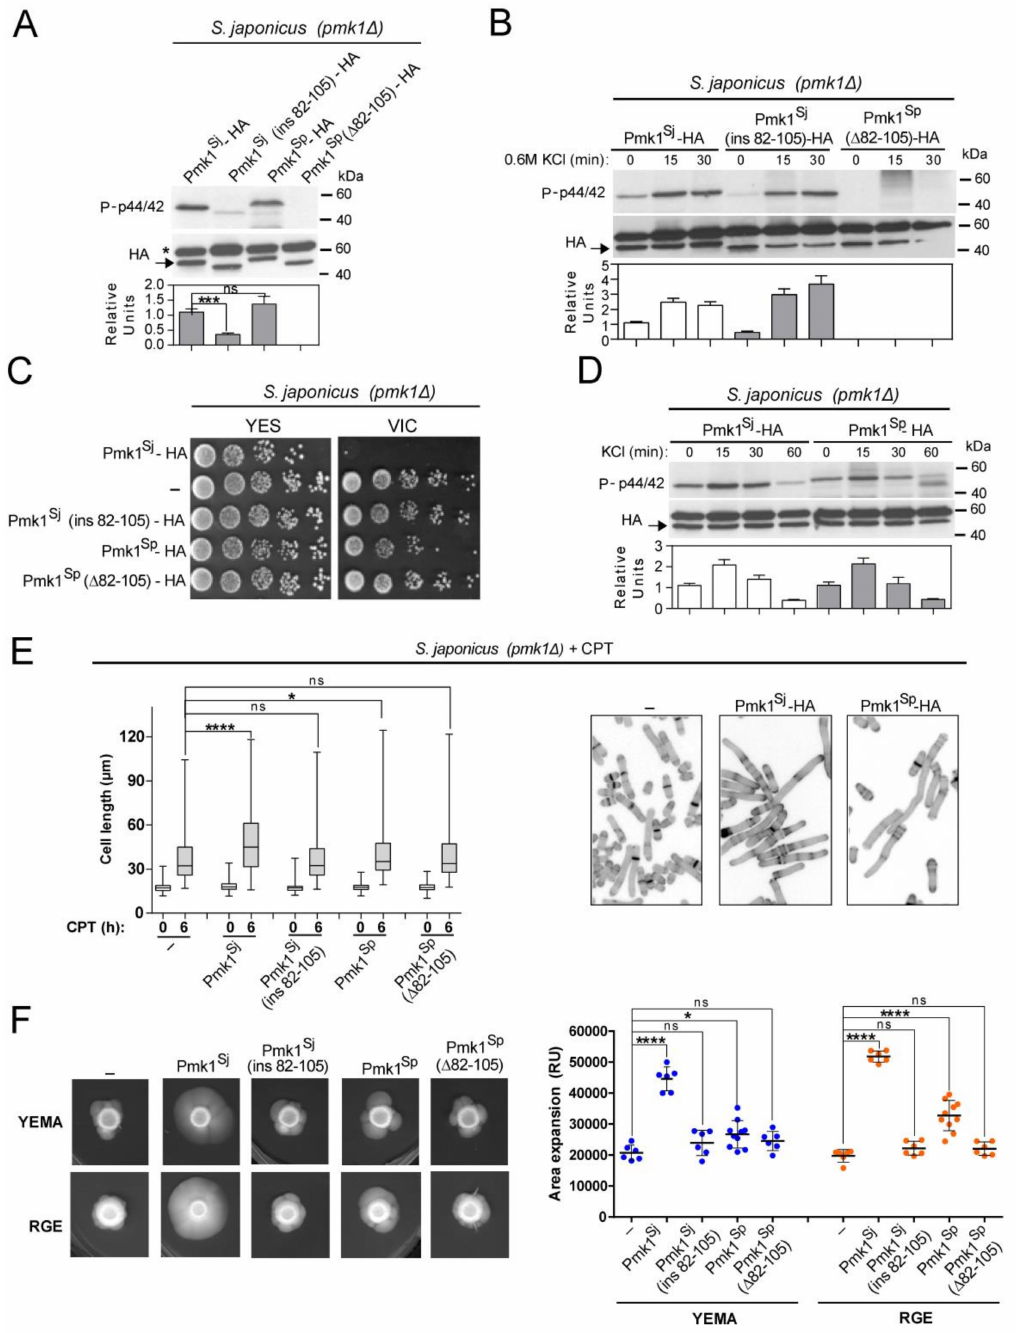
Figure 4. S. pombe Pmk1 shows little ability to execute CIP functions and to promote mycelial development in S.